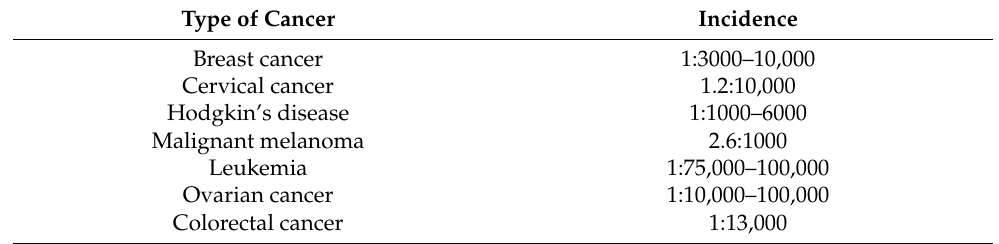
Table 3. Incidence of leading types of maternal cancer during pregnancy (data from Pavlidis,